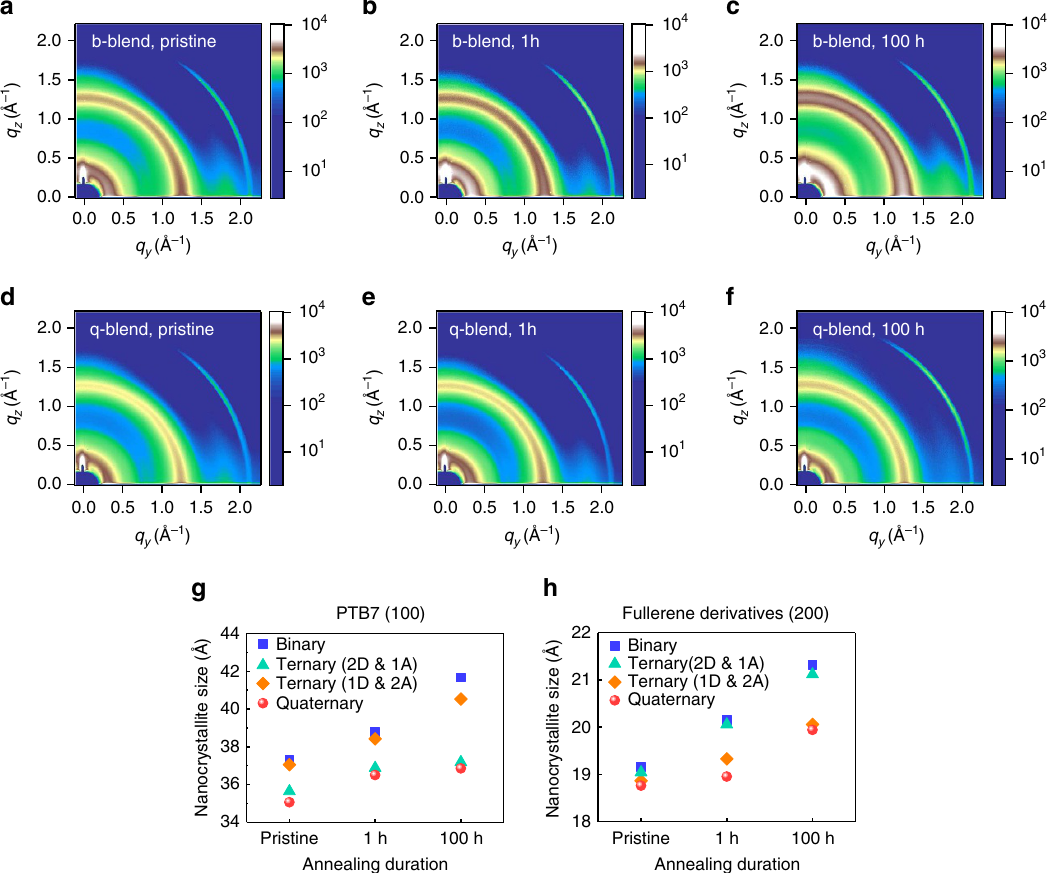
Figure 4 | Nanoscale domain size analysis. ( a – f ) 2D GIWAXS patterns of b- and q-blends for different annealing durations at 65 (cid:2) C. Nanocrystallite size as a function of thermal treatment time for b-, t- (2D & 1A or 1D & 2A) and q-blends according to ( g ) PTB7 (100) and ( h ) fullerene derivatives (200). The active layer of the ternary device (2D & 1A) consisted of PTB7:PCDTBT:PC 71 BM (0.9:0.1:1.5), while the ternary device (1D & 2A) was based